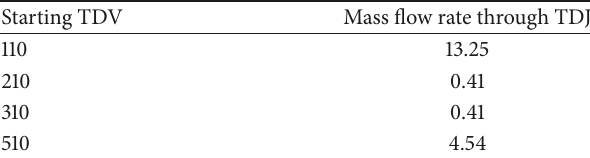
Table 6: Record of mass flows from TDVs. Starting TDV Mass flow rate through TDJ